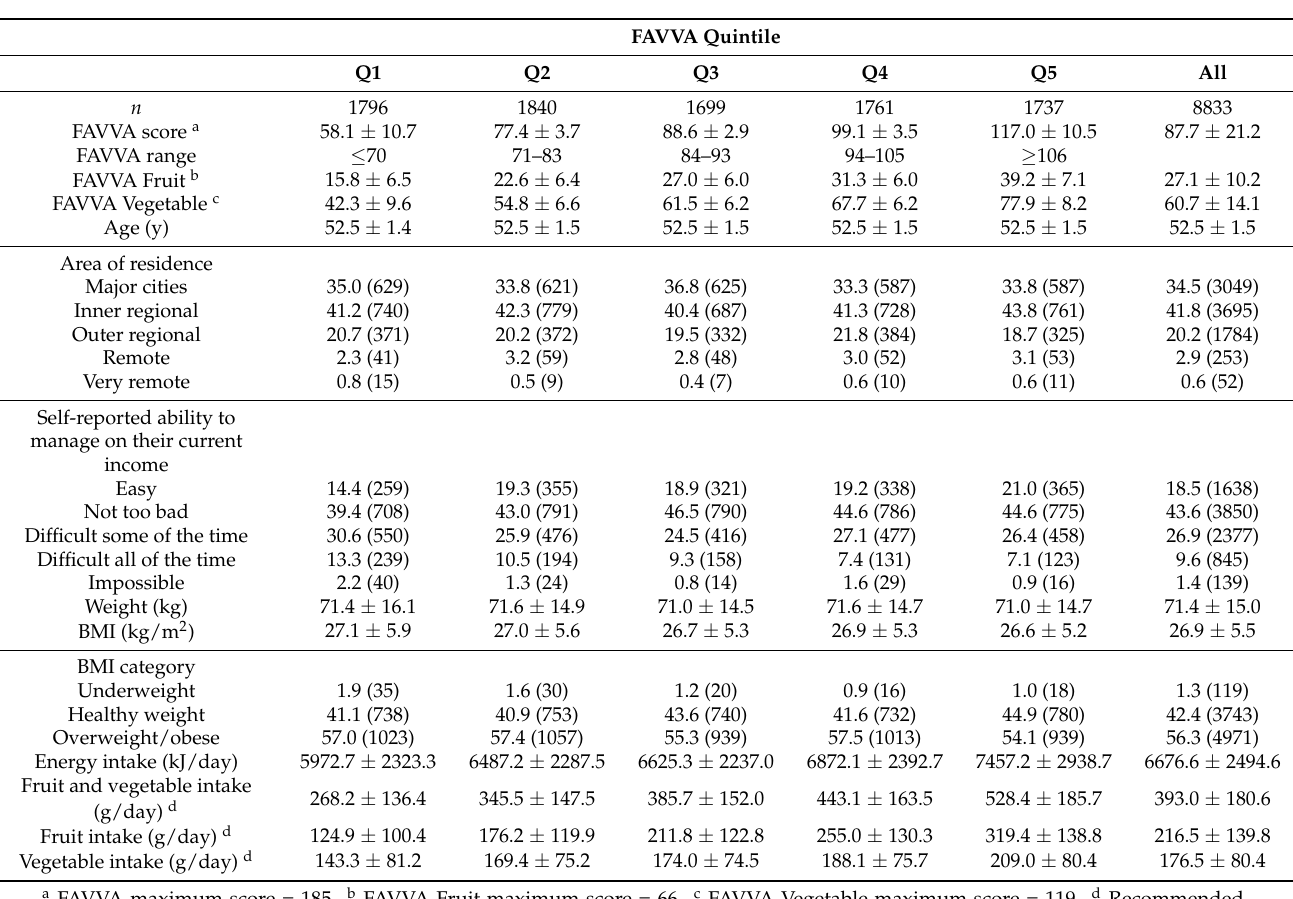
Table 1. Characteristics of the women in the 1946–1951 ALSWH cohort according to the Fruit and Vegetable Variety (FAVVA) scores for Survey 3 (2001, n =